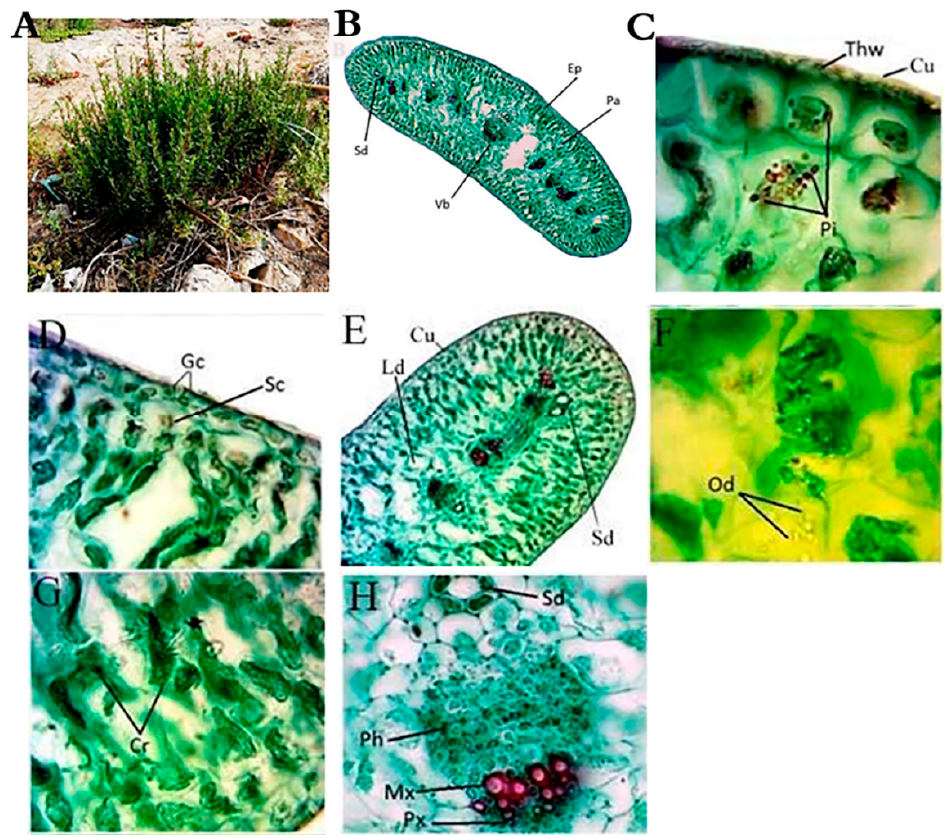
Figure 2. Morphology and anatomy of L. crithmoides leaf. ( A ) Morphology, ( B ) A transverse section in leaf showing the general view, Ep: epidermis, Pa: palisade tissue, Sd: schizogenous duct, Vb: vascular bundle; ( C ) phenolic idioblasts (Pi), Thw: thick wall, Cu: cuticle; ( D ) guard cells (Gc), Sc: substomatal chamber; ( E ) lysigenous duct (Ld), Sd: schizogenous duct, Cu: cuticle; ( F ) Oil drops (Od); ( G ) crystals (Cr) and ( H ) enlarged vascular bundle (Vb), Mx: metaxylem, Px: protoxylem, Ph: phloem, Sd: schizogenous duct. Bar: B = 40 µ m, C–H = 400 µ m, E = 100 µ